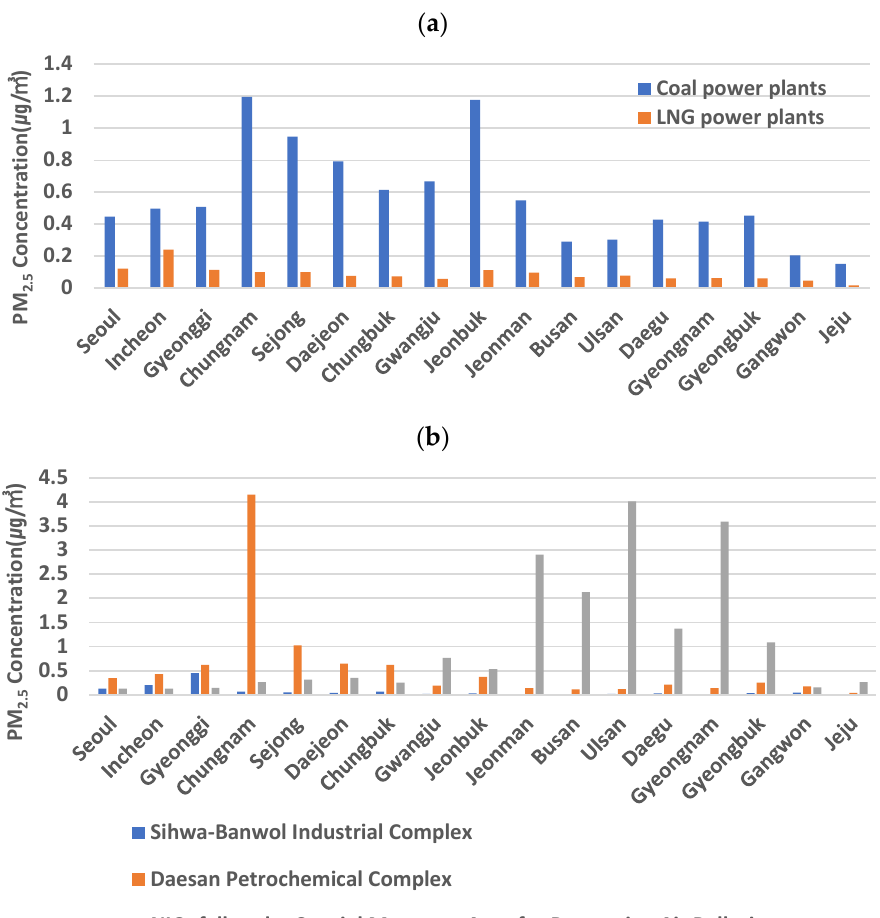
Figure 5. PM 2.5 contribution concentration for each region from emissions of ( a ) TPPs; and ( b ) NICs.